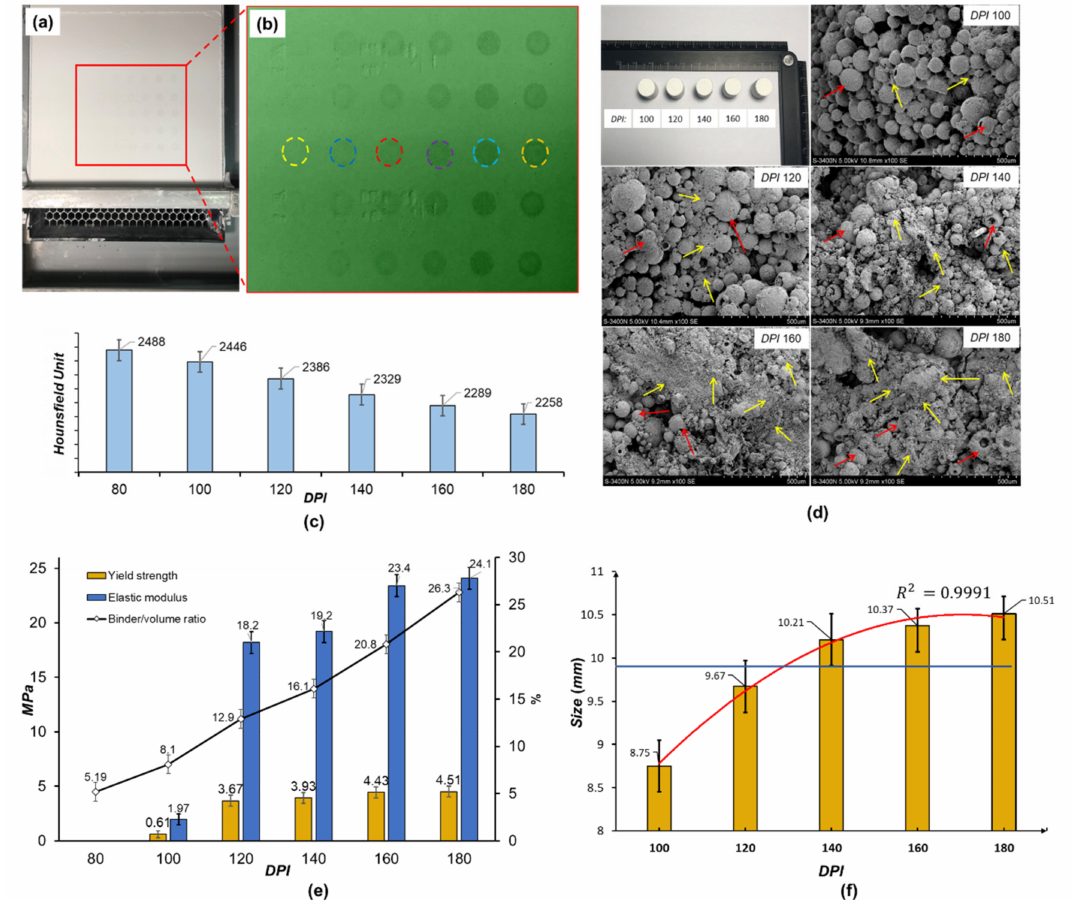
Figure 6. The characterization of 3D printed samples. ( a ) is the picture of powder bed taken during the printing process. ( b ) is the partial enlargement for the analysis of the binder print resolution according to graphic image analysis ( c ) is the histograms of Hounsfield Units with image analysis software. ( d ) are the cross-section SEM images of printed samples, where the small balls indicated by red arrows are bioceramic particles, and the irregular objects covering the ball indicated by yellow arrows are the cured binder. ( e ) is the mechanical properties and binder/volume ratio of samples printed in different resolution. ( f ) is the geometrical accuracy analysis of samples printed in different resolution. The blue solid line is the target value, and the red line is the trend